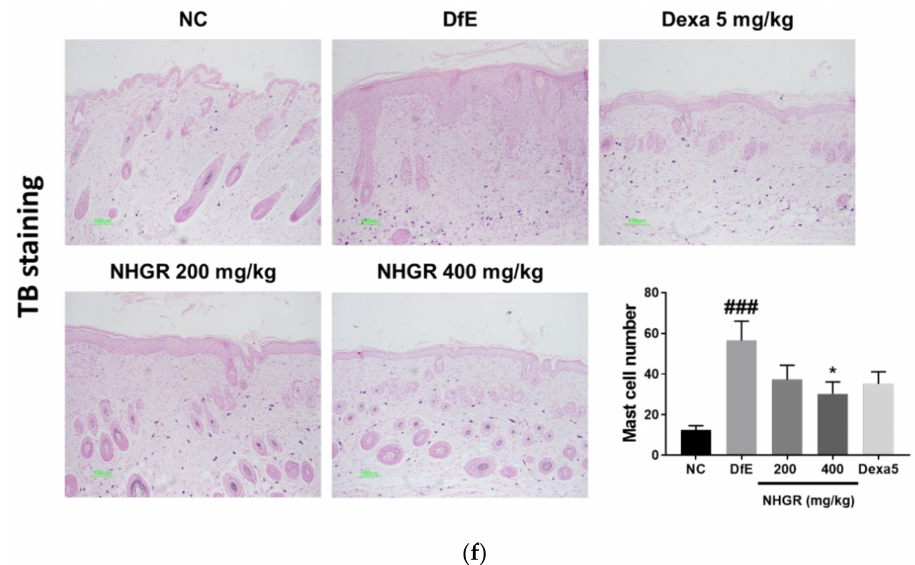
Figure 3. The e ff ects of Siraitia grosvenorii residual extract (NHGR) on the symptoms of atopic dermatitis in mice. ( a ) Ear thickness, ( b ) dermatitis score, ( c ) body weight, and ( d ) serum total IgE concentration. Dorsal skin sections were stained with ( e ) hematoxylin and eosin as well as ( f ) toluidine blue. Epidermal thickness and number of mast cells in the stained sections were evaluated. TB, toluidine blue stain; H&E, hematoxylin-eosin stain. Results are expressed as means ± SEM ( n = 7). ## p < 0.01 and ### p < 0.001 compared with NC; * p < 0.05, ** p < 0.01, and *** p < 0.001 compared with Dermatophagoides farinae extract